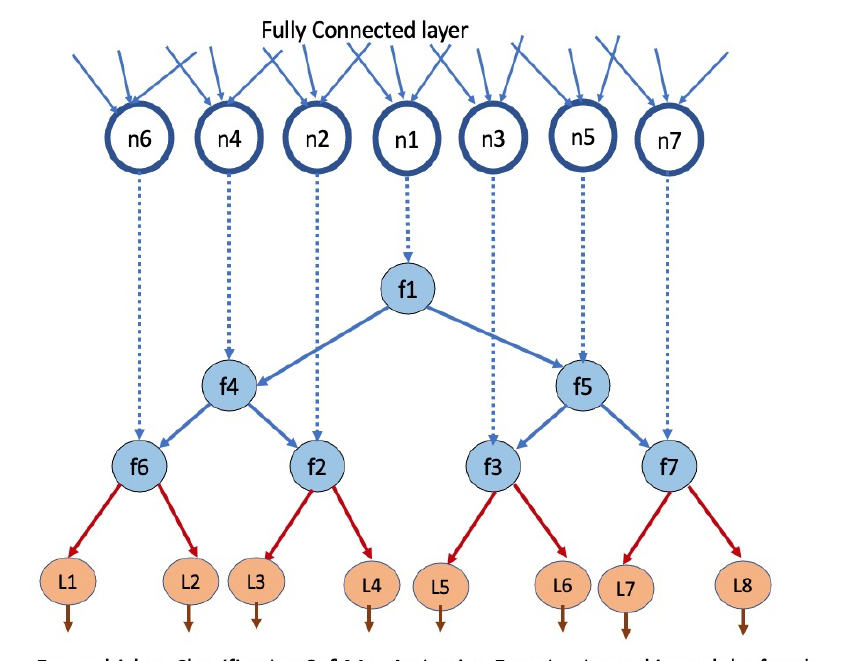
Figure 1. Architectural overview of the proposed model. Illustration of how to implement a decision tree-based neural network. The routing (split) decisions are created when each output of f n is brought into correspondence with a split node in a tree. The assignment of output units to decision nodes can be performed in any order (the one we show allows a simple visualization). As a result of resolving the convex optimization issue, the circles at the bottom are leaf nodes containing probability distributions over the multiclass classification